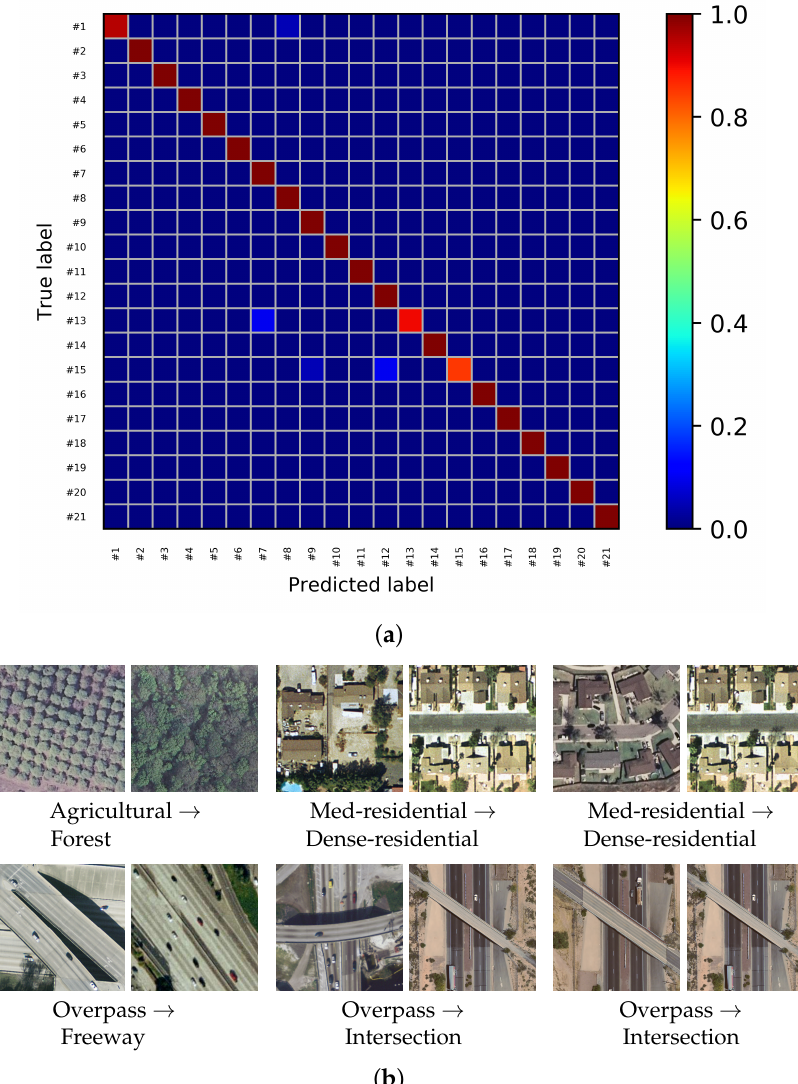
Figure 8. Confusion matrix and all misclassification examples for the UCM dataset using the proposed MDFR architecture. ( a ) Confusion matrix of the UCM dataset with OA = 98.57%. ( b ) Misclassified samples of the UCM